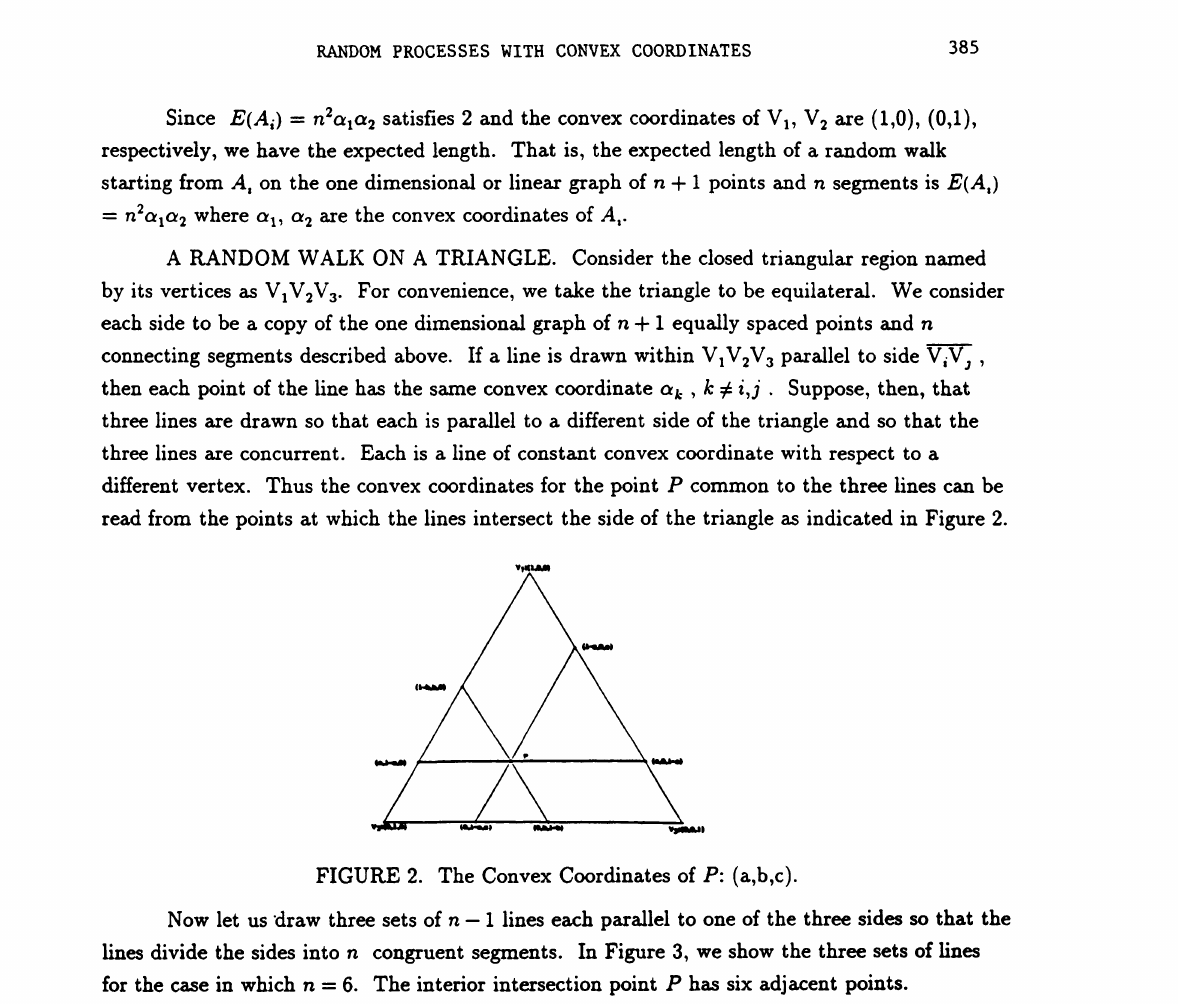
FIGURE 2. The Convex Coordinates of P: (a,b,c).